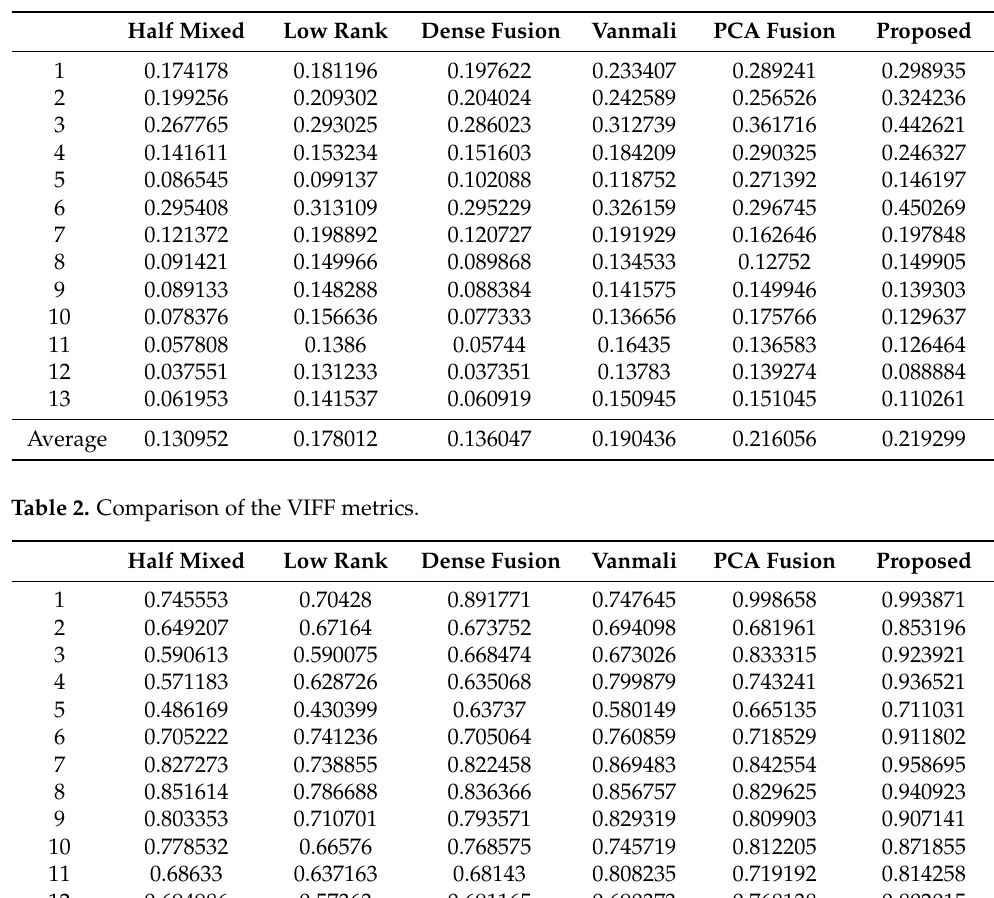
Figure 19. Comparison of the result images of the fusion methods. Low-rank fusion [6], Dense fusion [3], Vanmali fusion [2], PCA fusion [7]. Table 1. Comparison of the S3 image quality metrics.